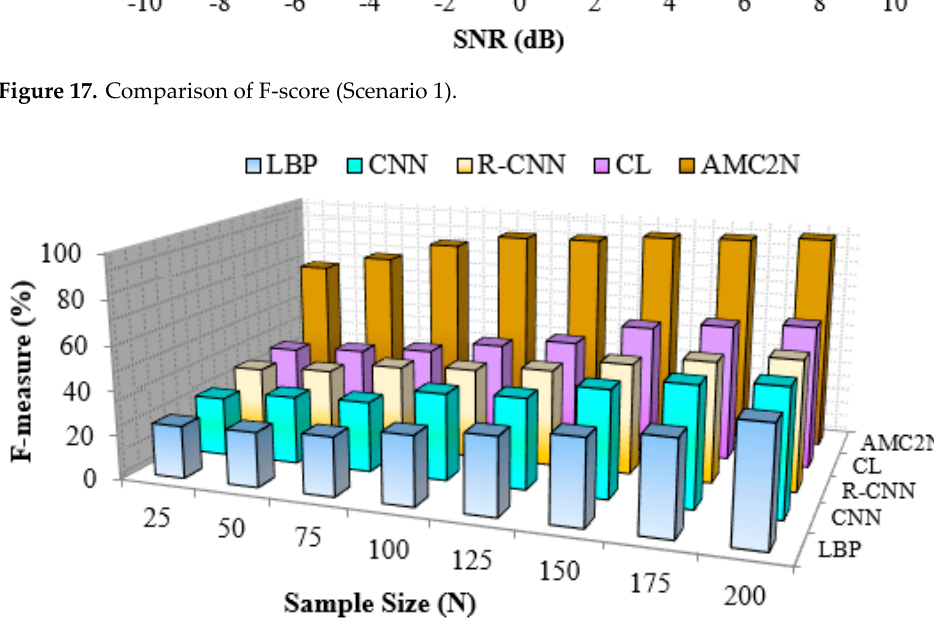
Figure 18. Comparison of F-score (Scenario 2).